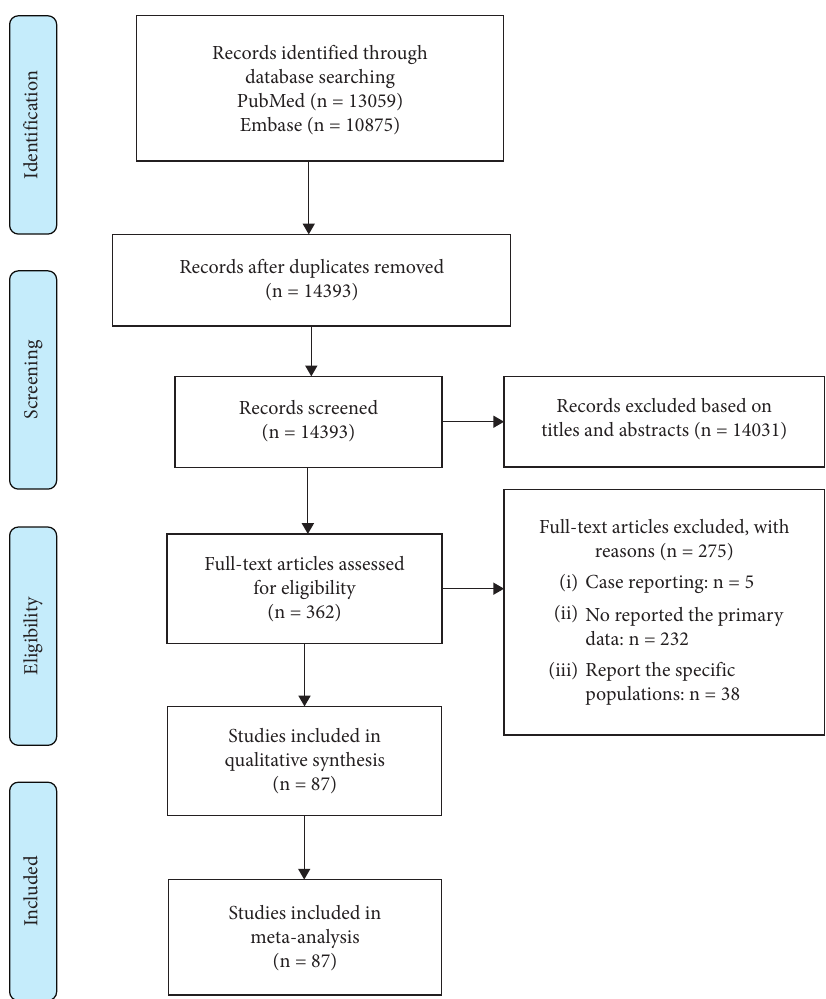
Figure 1: Study selection